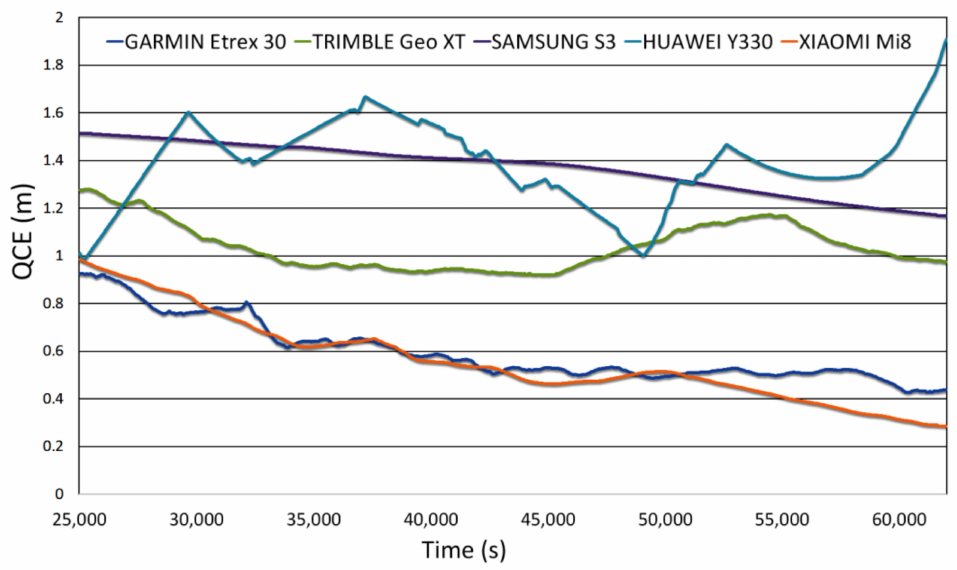
Figure 3. The relationship between the time and the quadratic composition of the East and North errors (QCE) of each device. From 25,000 to 60,000 s period of recorded data. East and North errors are the differences between the control point and coordinate